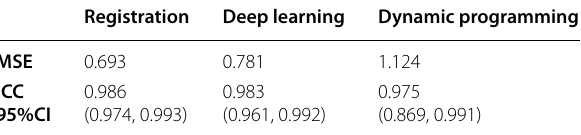
Table 2 Concordance of MagDensity derived using the automated algorithms and manual segmentation (reference standard)